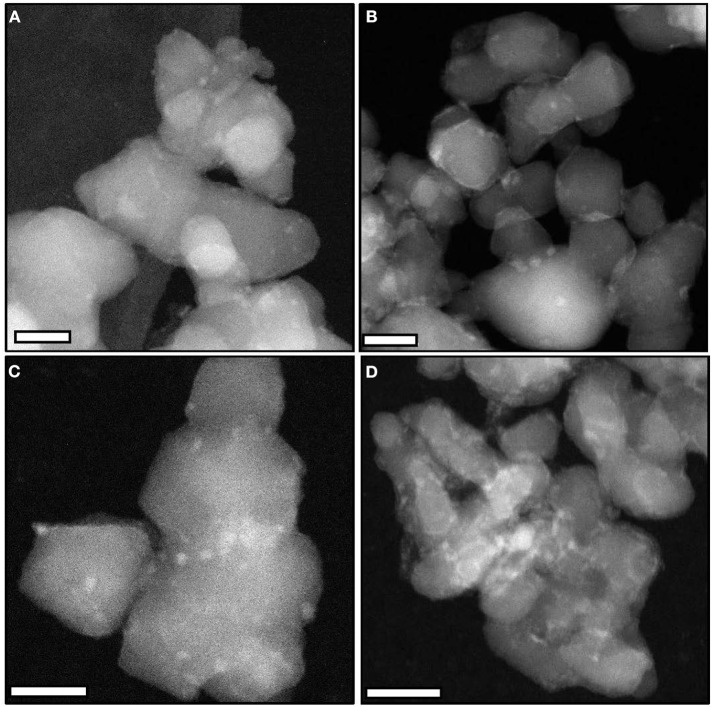
Representative STEM-HAADF images (scale bars, 20 nm) of (A) MoC/TiO2-P, (B) MoC10E−700/TiO2-P, (C) MoC10M−700/TiO2-P, and (D) MoC20E−700/TiO2-D.